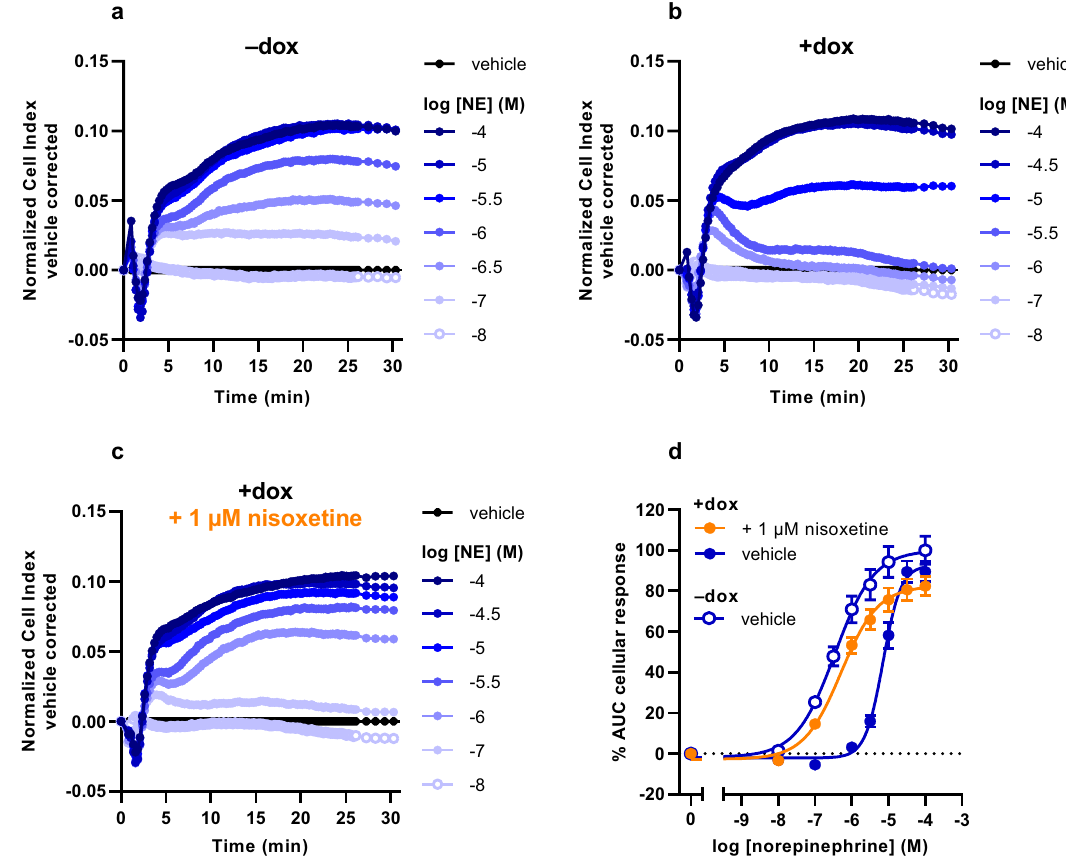
Figure 1. Characterization of the norepinephrine (NE) response on JumpIn-NET cells in the TRACT assay. Representative vehicle-corrected normalized Cell Index traces of vehicle-pretreated JumpIn-NET cells ( a ) in the absence (−dox) or ( b ) in the presence of 1 µg/ml dox (+dox). ( c ) Dox-treated cells were pretreated for 1 h with 1 µM nisoxetine prior to stimulation with NE. ( d ) Combined concentration-effect curves of NE on vehicle- or dox-treated JumpIn-NET cells. Cellular response is expressed as the net AUC of the first 30 min after stimulation. Data are normalized to the response of 100 µM NE on vehicle-treated (–dox) cells. Data are shown as the mean ± SEM of three to eight individual experiments each performed in duplicate.